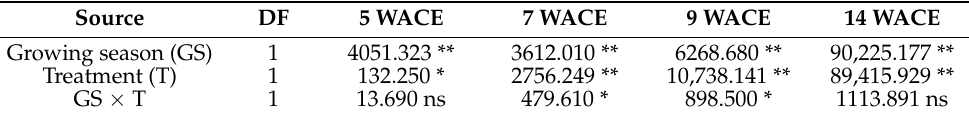
Table 2. Analysis of variance (mean squares) for the dry weight of white lupine plants at each